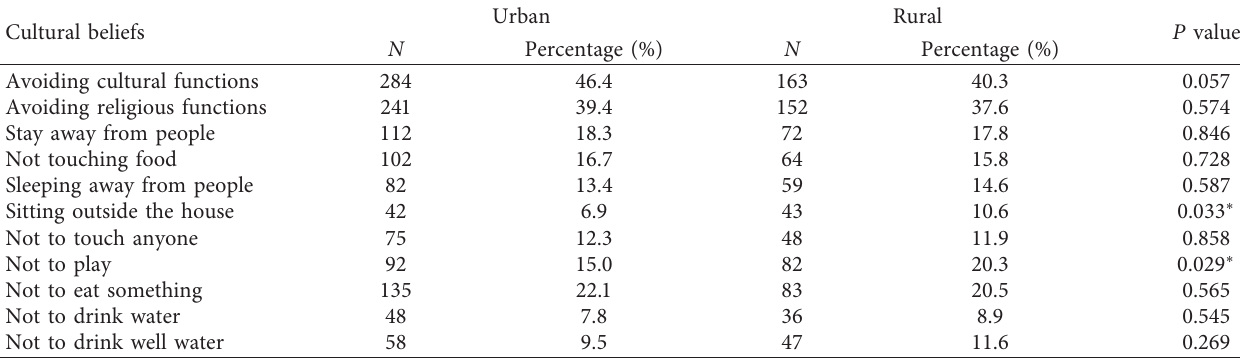
Table 5: Cultural beliefs practiced by the participants by the place of residence.